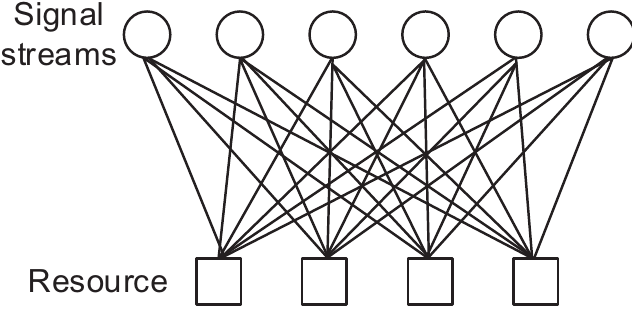
Figure 1. Factor graph of DSM with 6 signal streams and 4